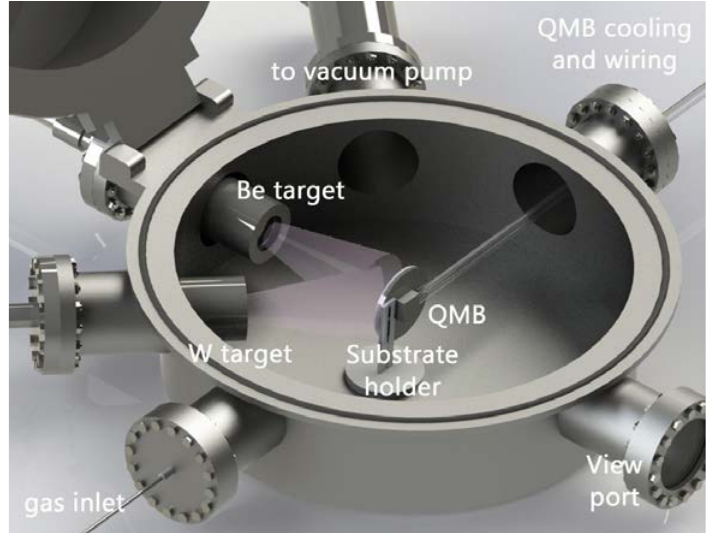
Figure 1. Schematic representation of the deposition setup used for obtaining D containing BeW mixed layers. The QMB was positioned in the center of the substrate holder to measure the deposition rates and thickness in